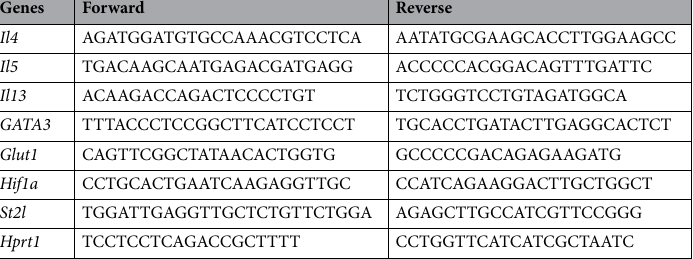
Table1. Primers for